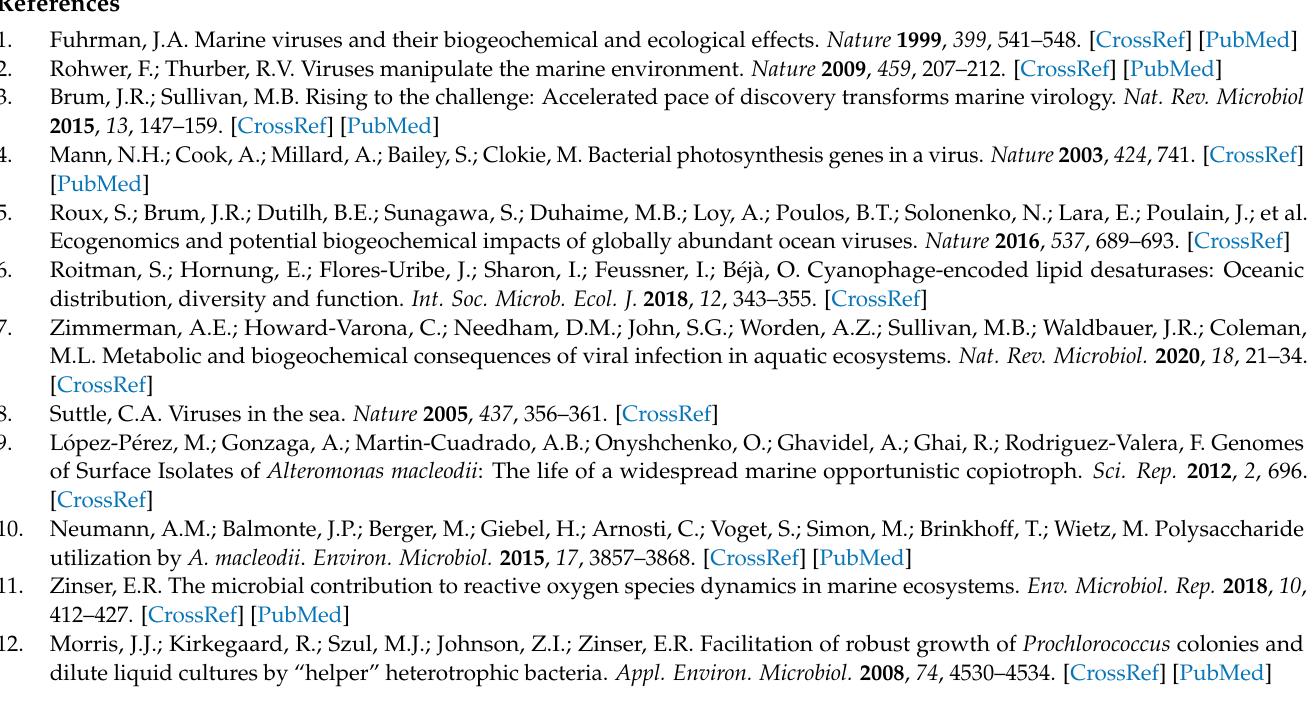
Table S2. vB_AmeP-R8W (R8W) gemone annotation; Table S3. The genetic comparison of the phage Figure S1. Station map indicating location where vB_AmeP-R8W (R8W) was isolated. Supplementary Data 1. Results of R8W PhageTerm